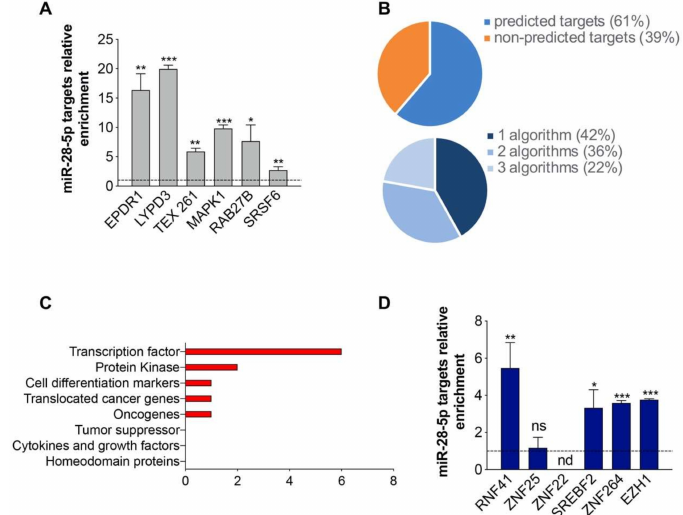
Figure 3. Analysis of miR-28-5p targetome. ( A ) Evaluation of the enrichment of miR-28-5p selected targets in the miR-28 BIO compared to miR-28 CT pull out samples by qRT-PCR. ( B ) Pie chart representing the percentage of the predicted / non-predicted targets (upper panel) and the percentage of the targets predicted by one, two or three algorithms (lower panel) in the miR-28-5p targetome. ( C ) Results of the MSigDB gene sets analyses showing the identified genes families. ( D ) Enrichment of the miR-28-5p targets belonging to the “transcription factors” family in the miR-28 BIO compared to miR-28 CT pull out samples by qRT-PCR. * p < 0.05, ** p < 0.01, *** p < 0.001, unpaired t